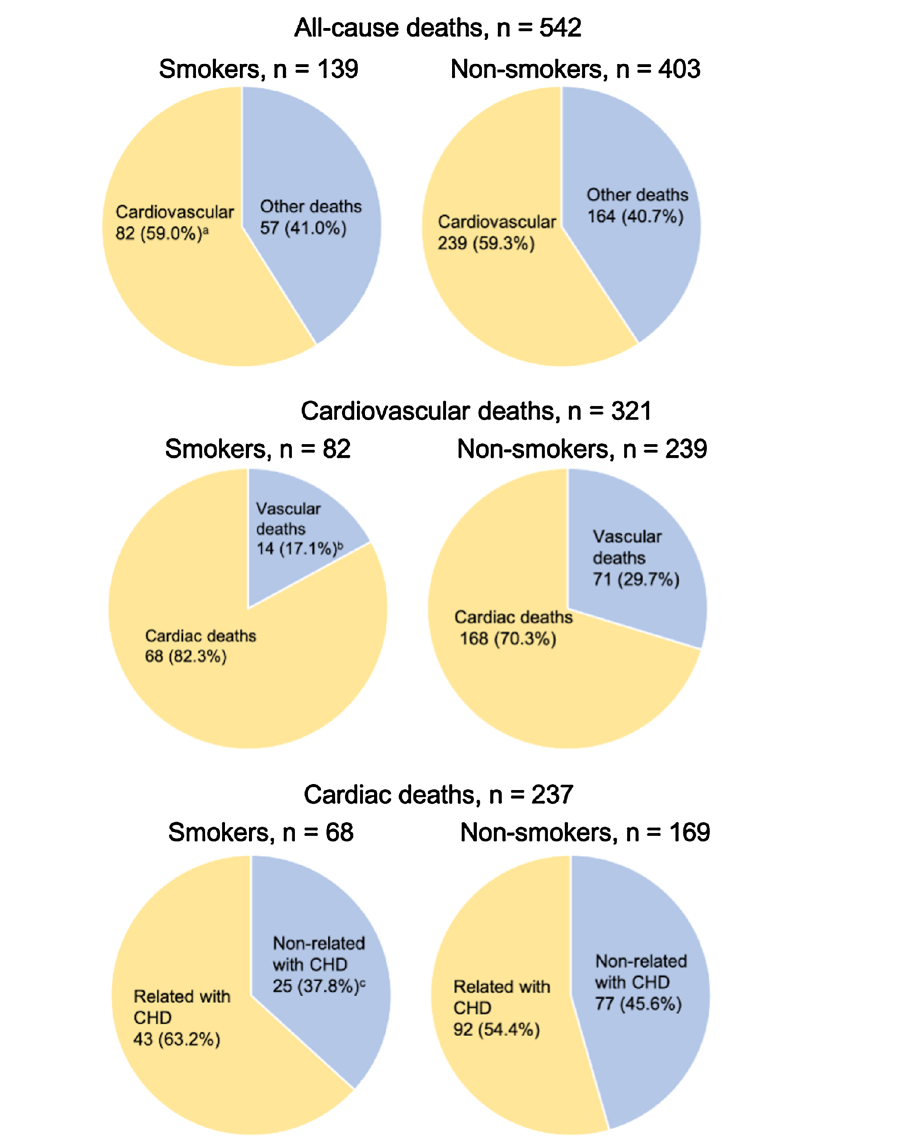
Figure 1. Prevalence of cardiovascular-related deaths in hemodialysis smokers and